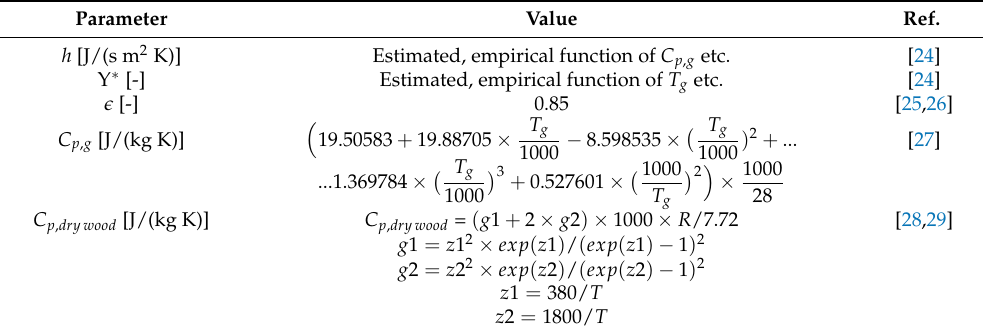
Table 1. Input parameters to the 0D